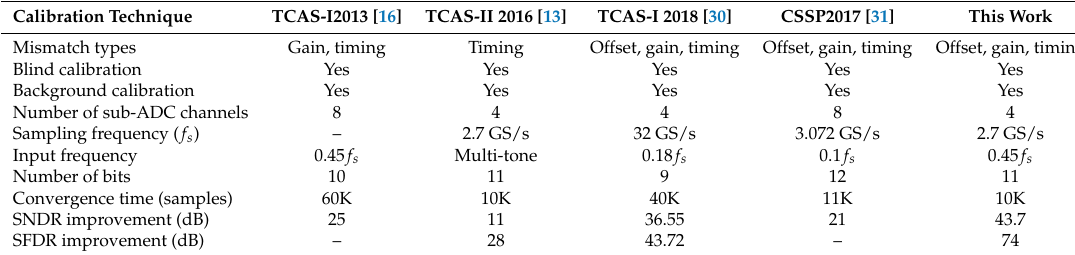
Table 2. The comparison results with the state-of-the-art